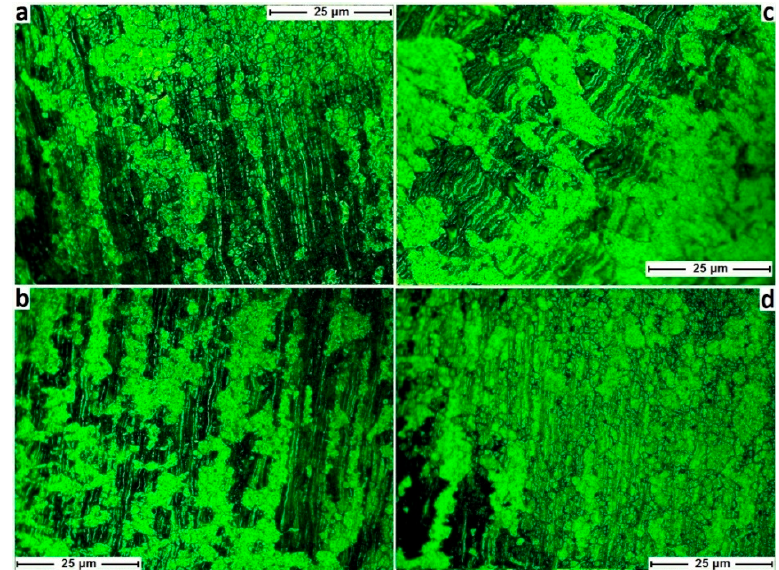
Figure 7. Morphological transition of grain flow in the HAZ processed by etchant E: ( a ) top shoulder-A.S; ( b ) bottom shoulder-A.S; ( c ) top shoulder-R.S; and ( d ) bottom shoulder-R.S.